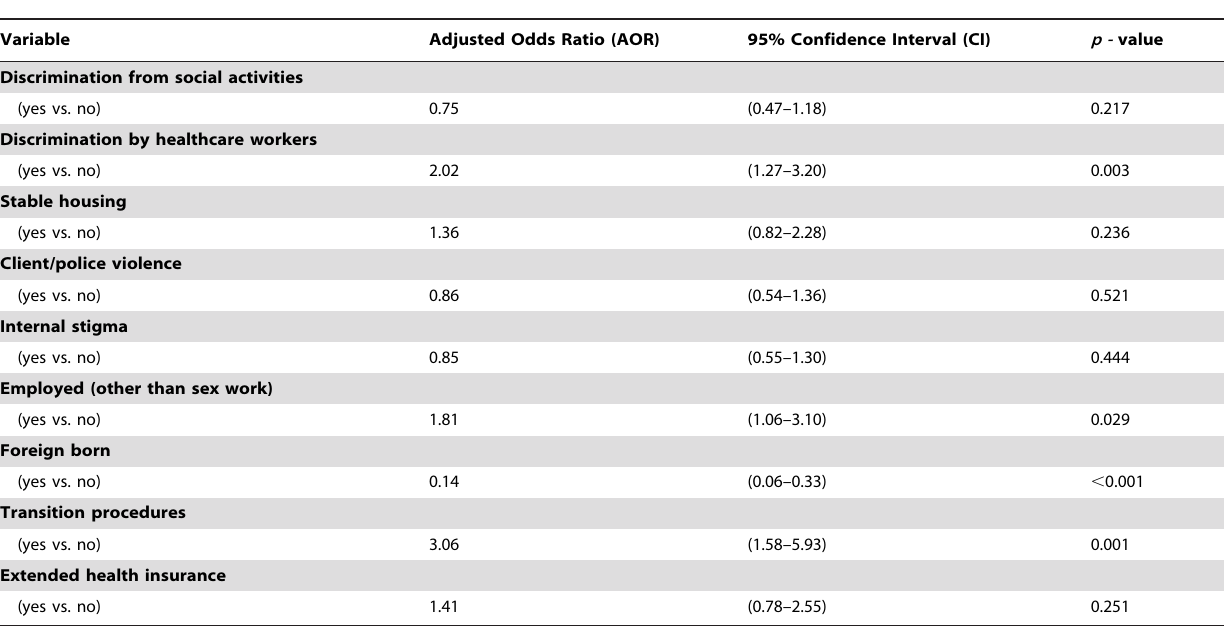
Table 2. Multivariate logistic regression of factors associated with acquiring a new gender-congruent ID among transwomen in Argentina